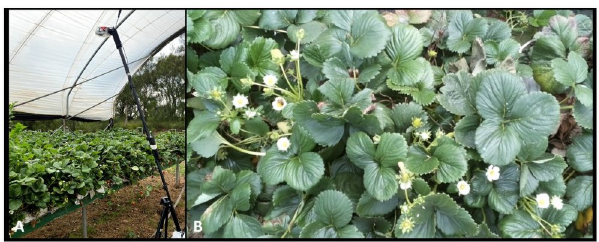
Fig 3. Video-capture detail. (A) Raspberry Pi and camera setup in the strawberry fields. (B) A frame from the recorded video.